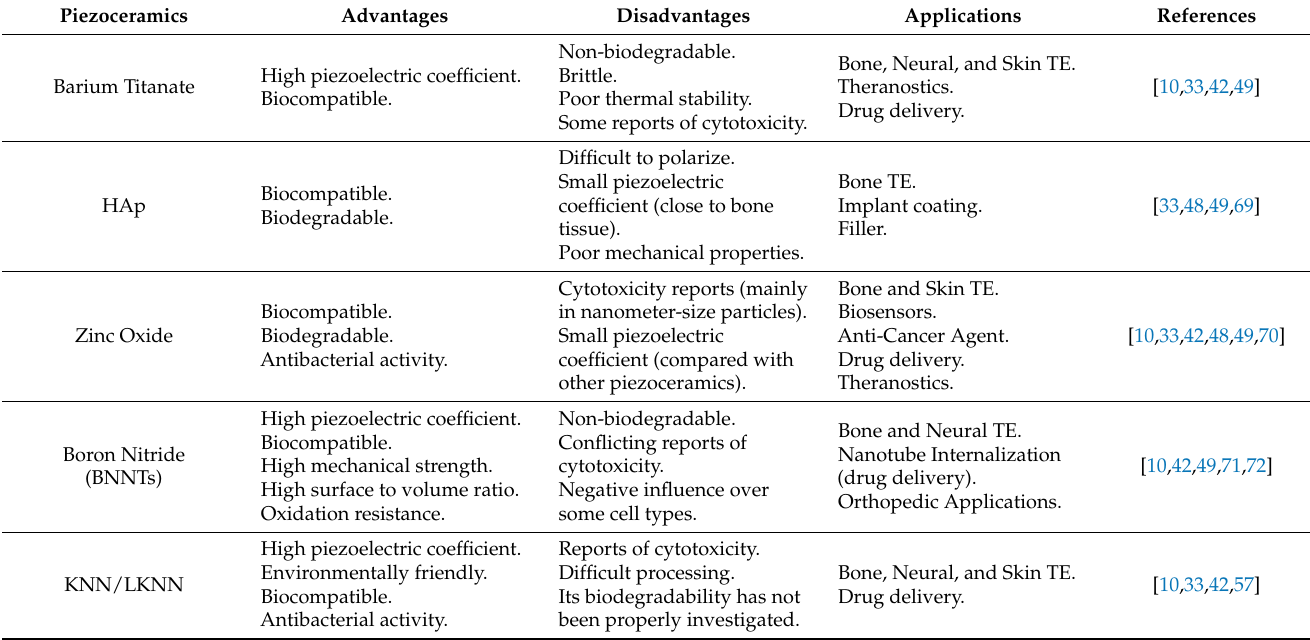
Table 3. Summary of main piezoceramics that have been applied so far in piezoelectric scaffold-based TE